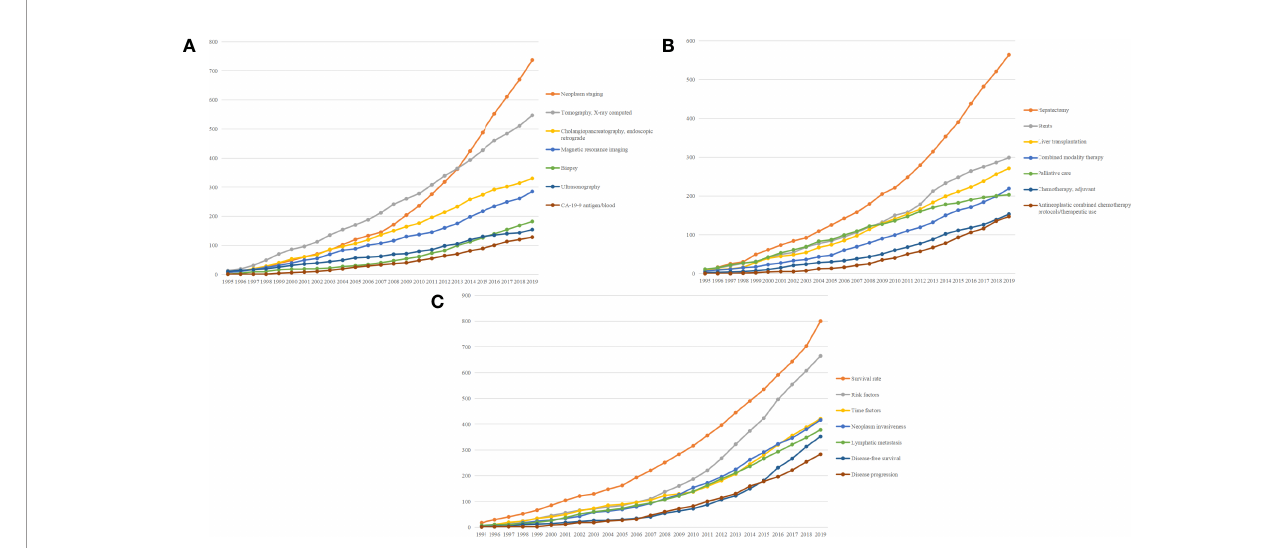
FIGURE 4 | Top 7 MeSH terms concerning diagnosis (A) , treatment (B) , and prognosis (C) of cholangiocarcinoma and accumulative occurrences during the past 25 years.